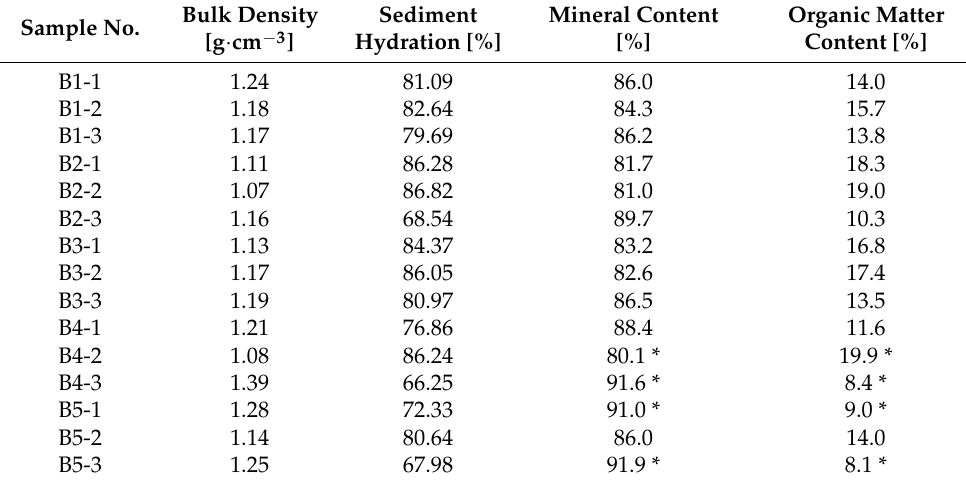
Table 5. Density and content of organic and mineral matter in bottom sediments. Sample No.